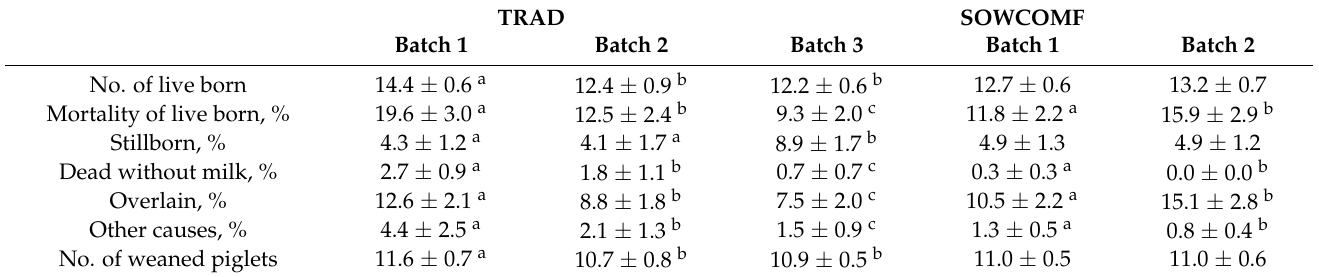
Table 2. Production results (means ± SE) from the first farm during the three first batches of TRAD (Traditional: n = 61 L) followed by two consecutive batches in SOWCOMF (SowComfort farrowing pen: n = 57 L). Significant differences between each batch within pen type for all variables are denoted by different superscripts a, b, and c.